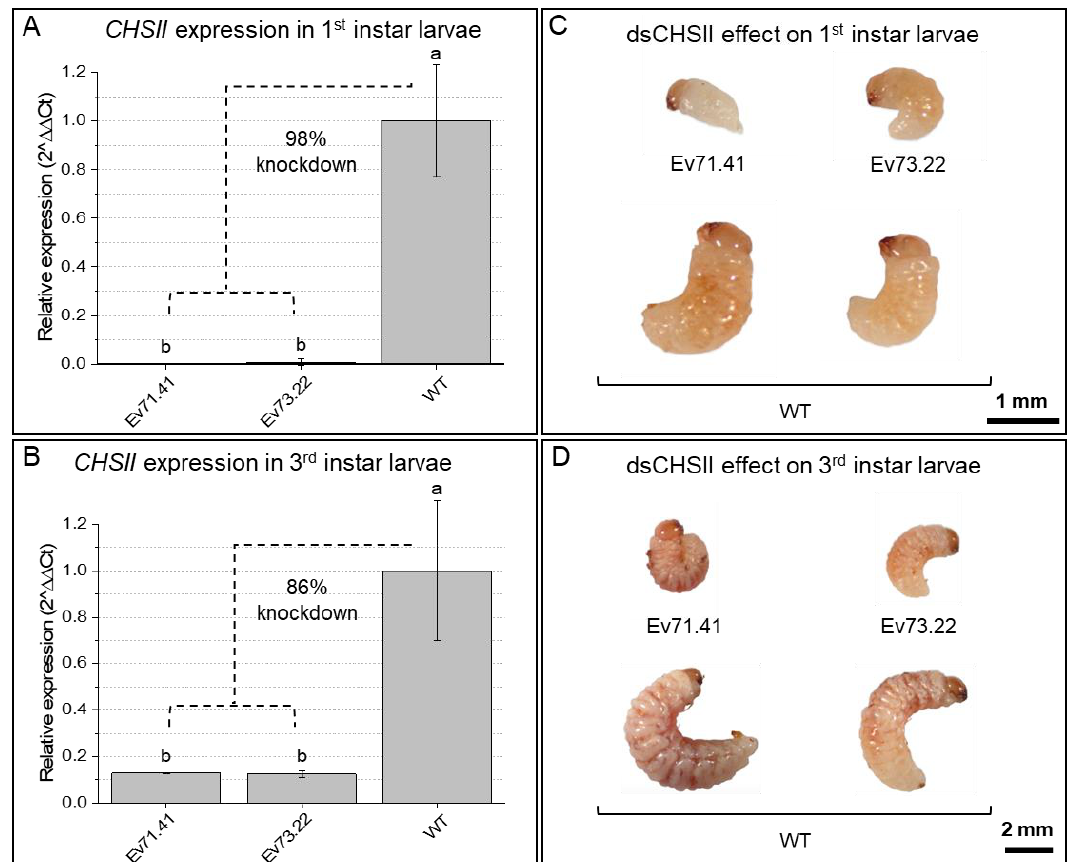
Figure 6. Effects of dsRNA-expressing plants in A. grandis individuals fed on cotton after hatching within oviposited buds. Individuals fed on transgenic cotton plants from different events (Ev) are compared to insects fed on wild-type cotton (WT). Different lowercase letters indicate significant differences between treatments ( t -test, Bonferroni corrected; p -value < 0.05). ( A ) Chitin synthase ( CHSII ) relative expression (RT-qPCR) in larvae after 5 – 7 days of feeding within cotton buds. N: 6 larvae per sample (3 samples per event). ( B ) CHSII relative expression (RT-qPCR) in larvae after 15 – 18 days of feeding within cotton buds. N: 3 larvae per sample (3 samples per event). ( C ) Phenotypic effect of gene silencing in first instar larvae after 5 – 7 days of feeding within cotton buds. ( D ) Phenotypic effect of gene silencing in third instar larvae after 15 – 18 days feeding within cotton buds.